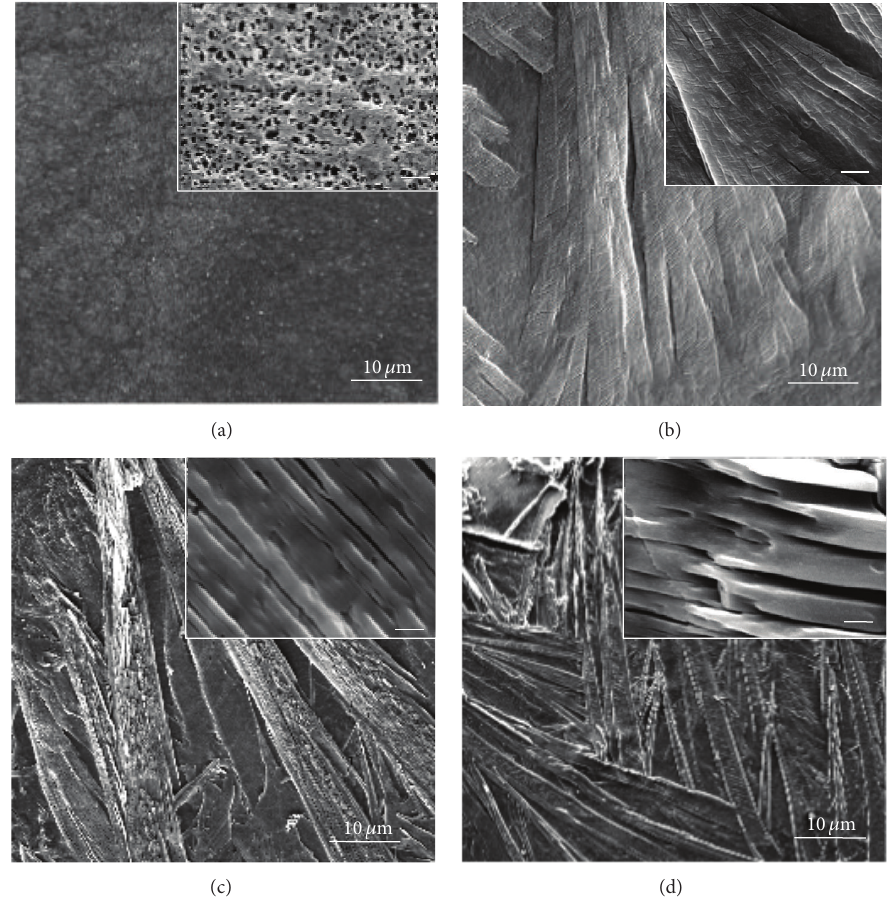
Figure 2: SEM images of the surface of the chitosan-ibuprofen composite hydrogel on titanium plate. Pure chitosan hydrogel (a); chitosan hydrogel with 0.2% ibuprofen (b); chitosan hydrogel with 0.6% ibuprofen (c); and chitosan hydrogel with 1.0% ibuprofen (d). The insert of each SEM image shows high magnified images (the scale bar was 2 𝜇